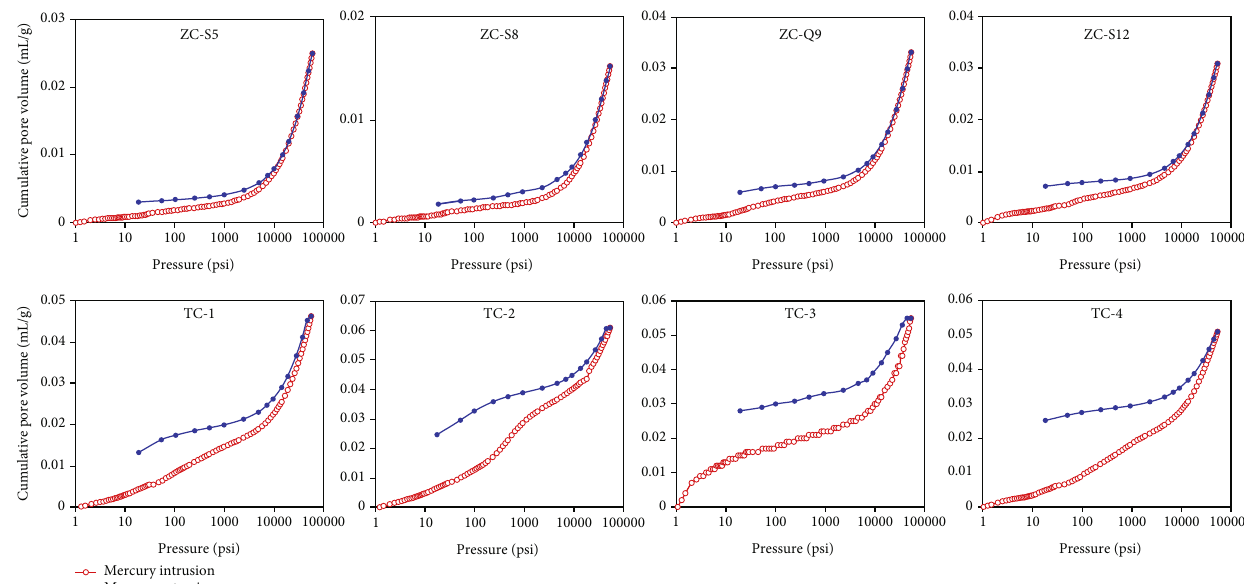
Figure 2: Mercury intrusion and extrusion curves of the coal